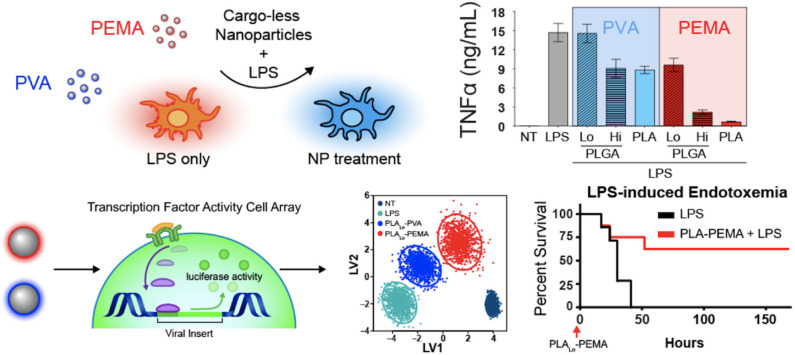
Immunomodulatory effects of nanoparticles. Nanoparticle-dependent inflammatory cytokine suppression of innate immune cells when stimulated with LPS (top). Dynamic transcription factor activity of bone marrow-derived macrophages treated with particles followed by LPS stimulation and improved survival in lethal LPS-induced endotoxemia model. PVA, neutral charge. PEMA, negative charge. Adapted from (93). Copyright (2019) Elsevier.